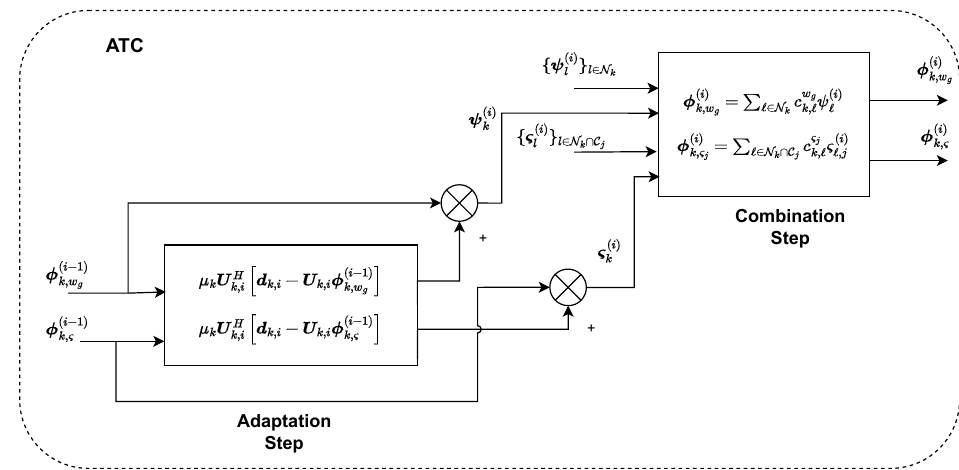
Figure 2. Illustration of Adapt-Then-Combine method at SU node k